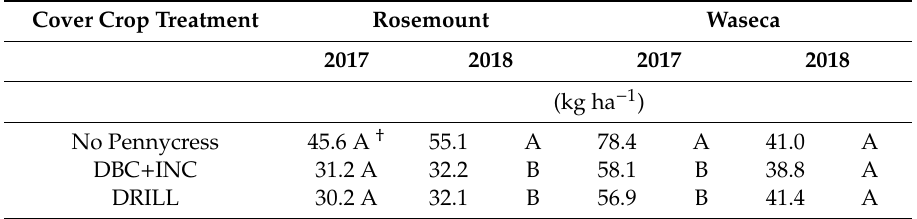
Table 5. Residual inorganic soil N (N min ) at pennycress harvest across cover crop treatments at Rosemount and Waseca, MN in 2017 and 2018 from 0–60 cm. Cover Crop Treatment Rosemount